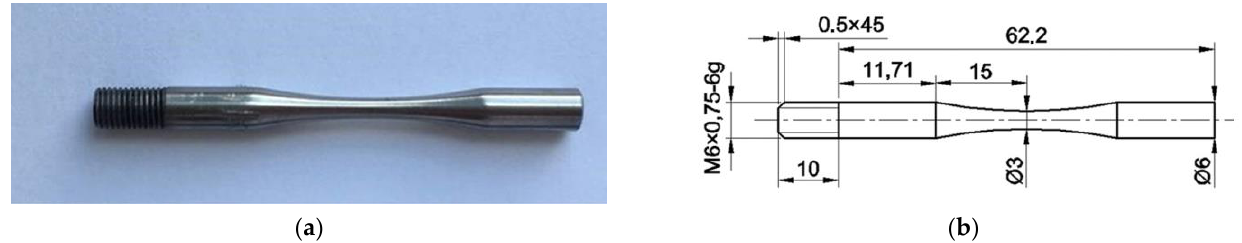
Figure 2. ( a ) Shape and ( b ) dimensions (in mm) of the Ti-45Nb alloy sample for fatigue-testing.